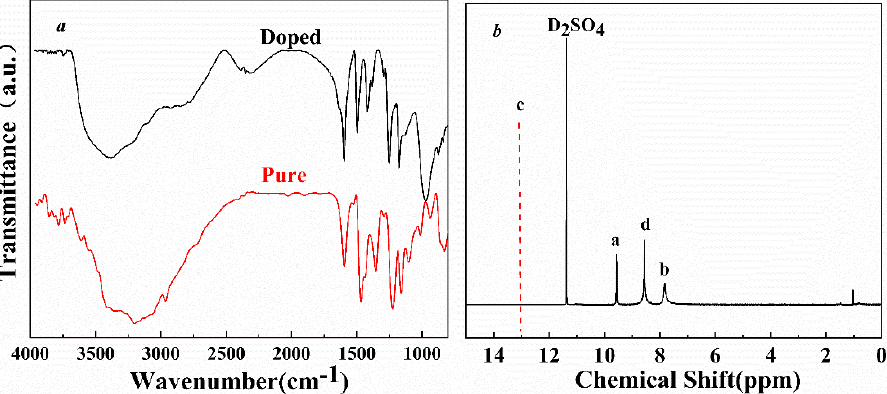
Figure 1. FT ‐ IR spectra of PPI and phosphoric acid ‐ doped PPI ( a ) 1 H NMR spectra of PPI in D 2 SO 4 ( b ).